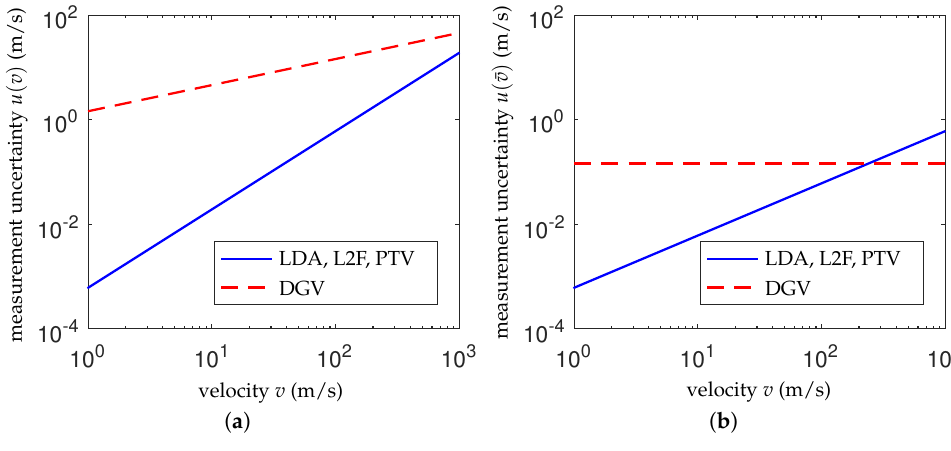
Figure 9. Minimal achievable measurement uncertainty due to photon shot noise over the flow velocity v for an average photon rate per particle of ˙ N photon = 2.7 10 8 s − 1 ( a ) for a single particle (that passes the measurement volume with the respective dimension w = 100 µ m) and ( b ) for multiple particles (that occur during the measurement time T = 0.1s). The formulas are from Table 2 and c 1 = 0.9, c 2 = c 3 = c 4 = 0.1, M = 1, λ = 532nm, τ ′ = 2GHz − 1 .